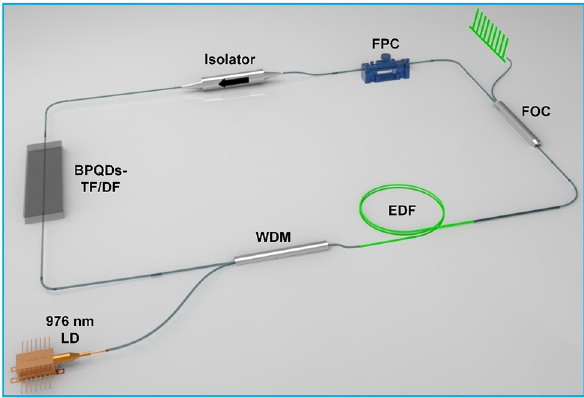
Figure 4: Schematic EDF laser setup with the incorporation of BPQDs-coated